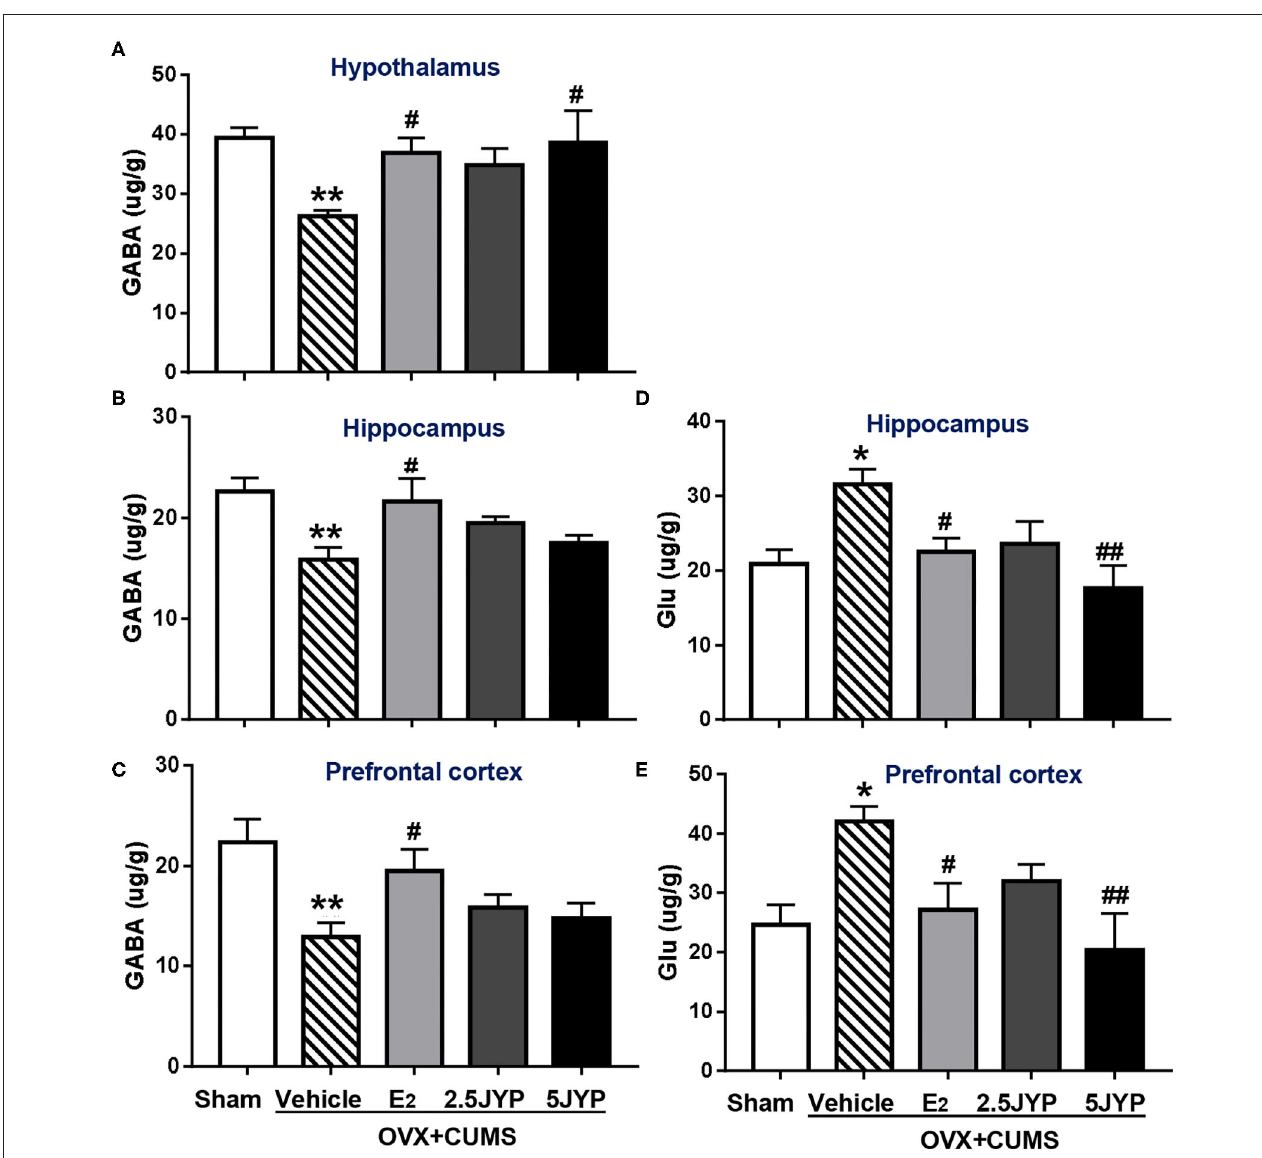
FIGURE 7 | Effects of 2.5 g/kg JYP (2.5 JYP), 5.0 g/kg JYP (5 JYP), and 0.3 mg/kg estradiol (E2) on brain regional γ -Aminobutyric acid (GABA) and glutamate (Glu) contents. (A) GABA in hypothalamus; (B) GABA in hippocampus; (C) GABA in prefrontal cortex; (D) Glu in hippocampus; (E) Glu in prefrontal cortex. Data are expressed as mean ± SEM ( n = 5–6) and examined with one-way analysis of variance (ANOVA), followed by post hoc between-group comparisons: * P < 0.05, ** P < 0.01 vs. sham group; # P < 0.05, ## P < 0.01 vs. vehicle